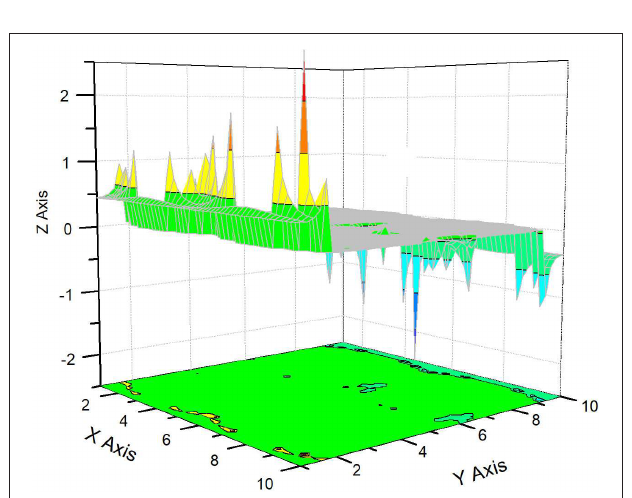
FIGURE 10 | Three curves y 1,2,3 ( j ) that were calculated with the help of expression (19) and correspond to the EQ-1 signal in 3D—DGI projection space. All 13 quantitative parameters are collected in Table 2